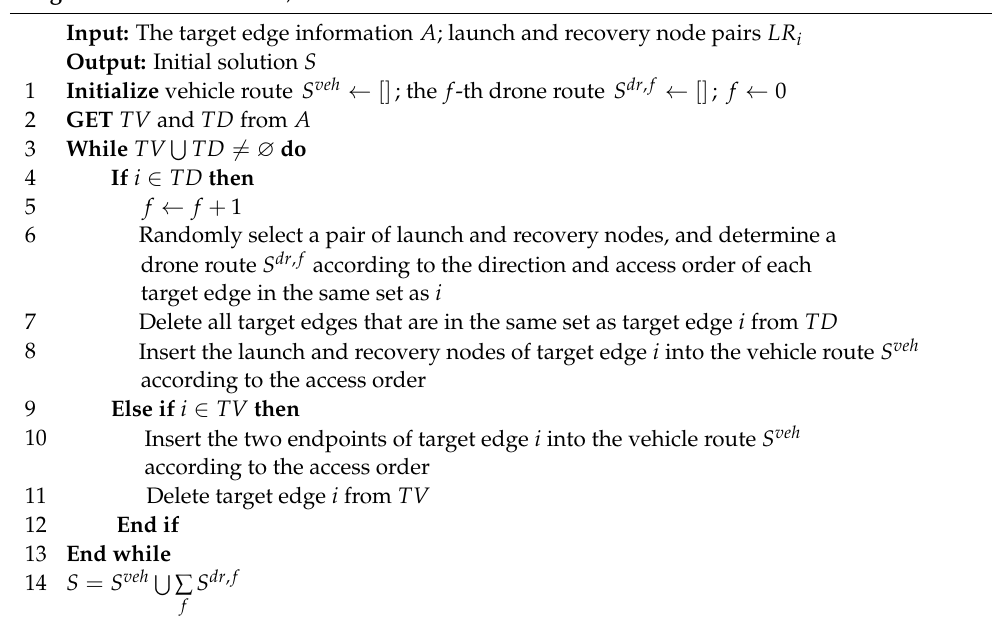
Algorithm 1: “Drone-First, Vehicle-Then” heuristic